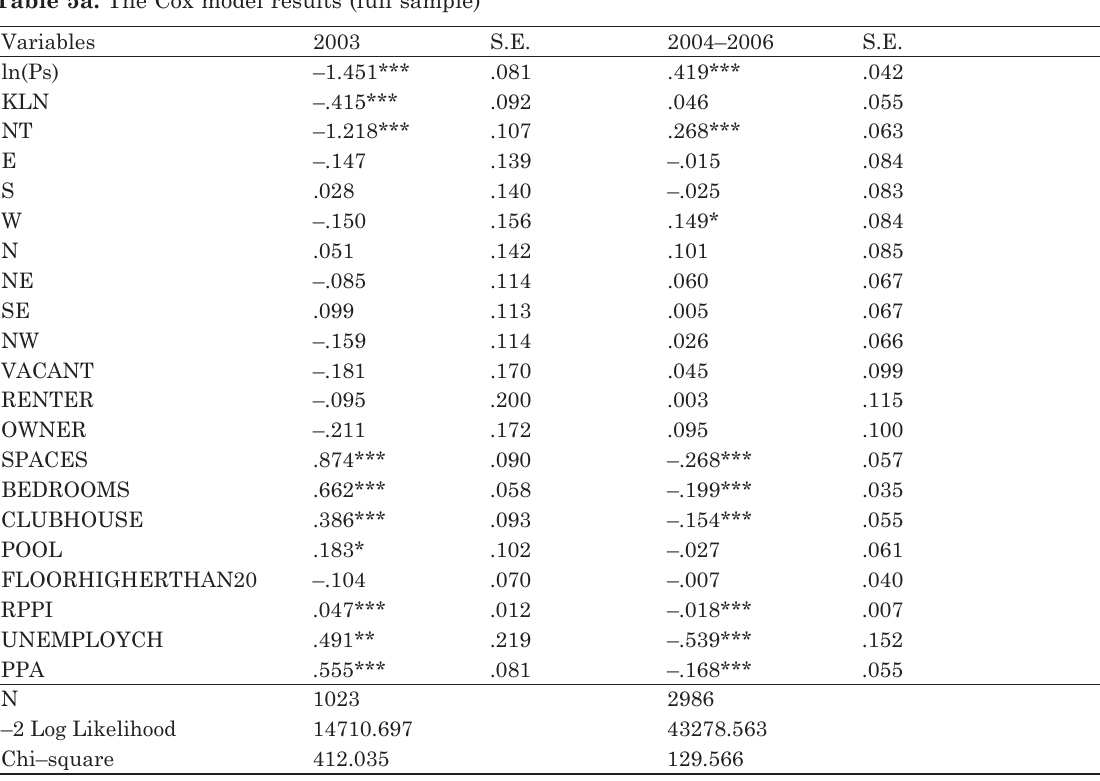
Table 5a. The Cox model results (full sample)